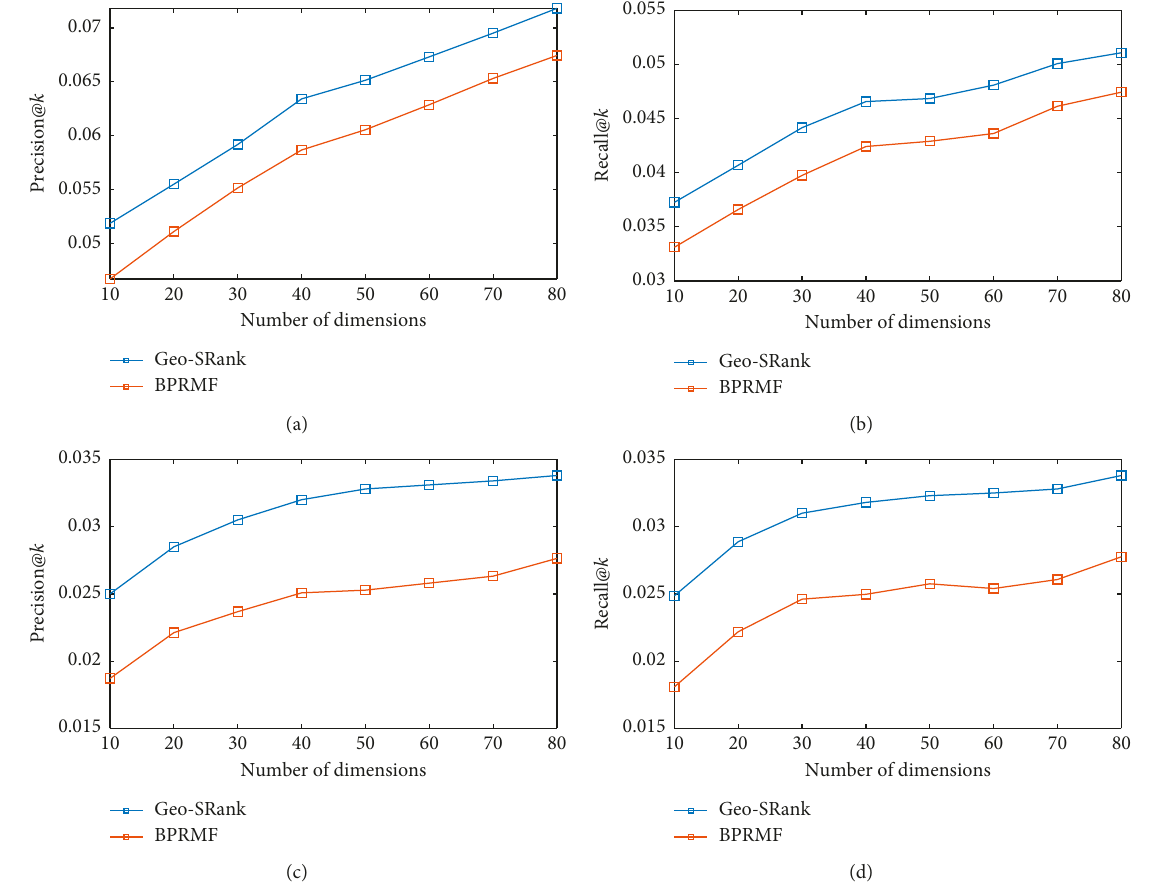
Figure 8: The experimental results with different latent factor dimensions. (a, b) Gowalla and (c, d)